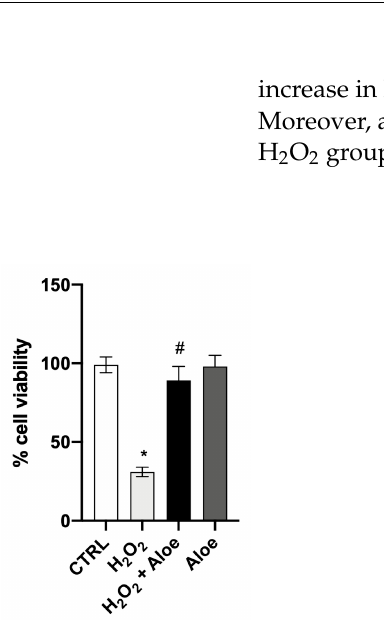
Figure 1. Effects of pre-treatment with aloe extract on cell viability ( A ), ROS production ( B ), MDA generation ( C ). Values are expressed as the means ± SD. * p < 0.0001 vs. CTRL; # p < 0.0001 vs. H 2 O 2 .